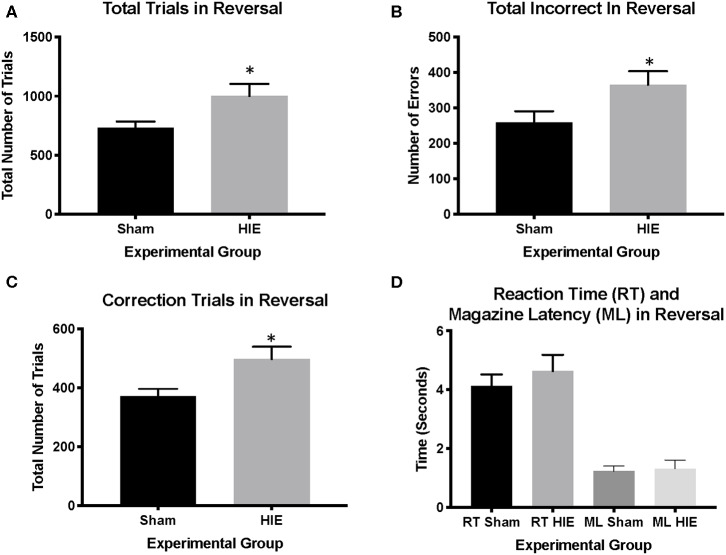
HIE induces reversal learning Deficits. The HIE group required significantly more trials to complete reversal compared to the sham group (A), as well as more incorrect responses during reversal (B). Additionally, the HIE group completed significantly more correction trials compared to the sham group (C). There was no difference in either the reaction time or magazine latency between the two groups during reversal (D) (n = 13–15, *p < 0.05). Data is represented as mean ± standard error of the mean (SEM).